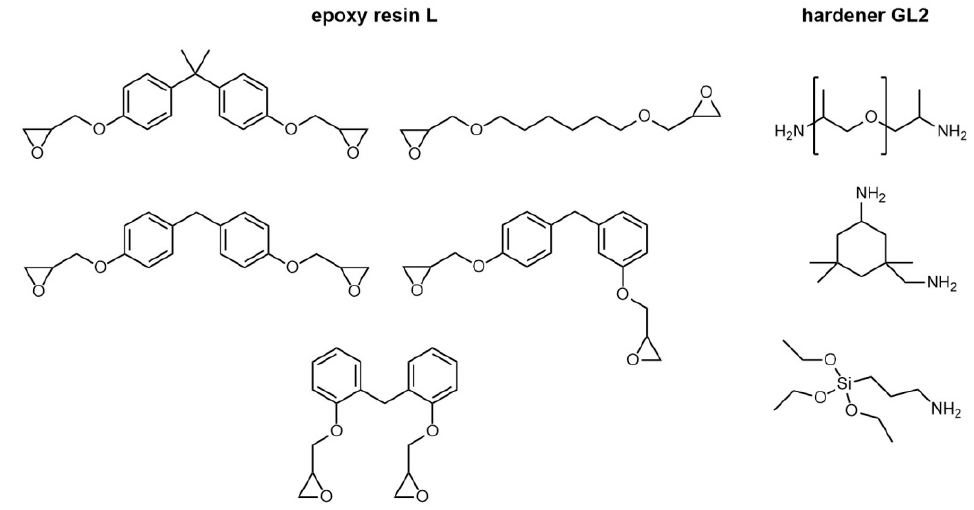
Figure 2. Chemical structures of the epoxy resin L (left) [45], and the hardener GL2 (right) [46]. The mixing viscosity of the resin hardener mixture (100:30 wt.%) at 20 °C was 248 mPa · s [47] with a processing time of 210 min. Curing was accomplished within 24 h